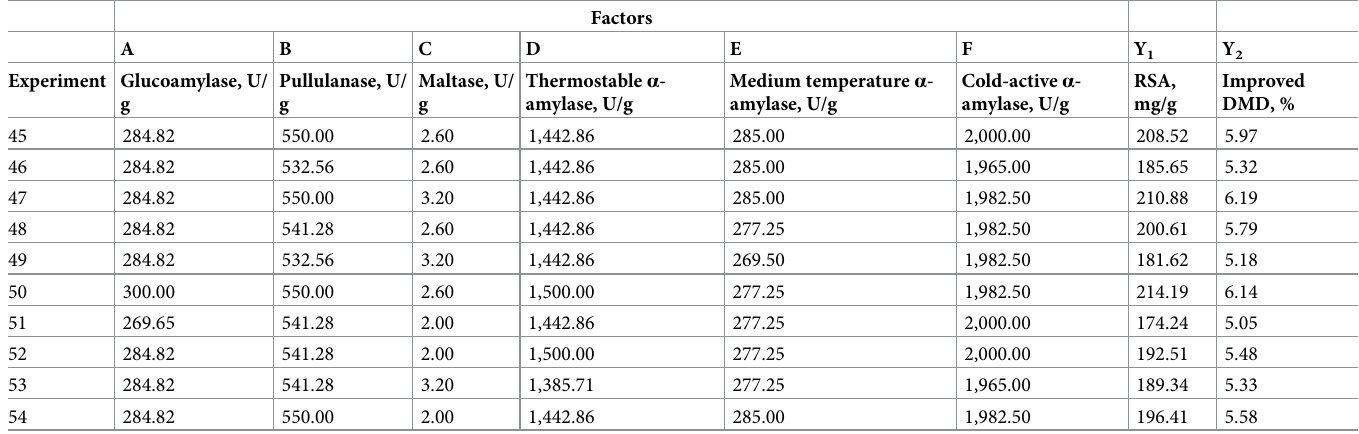
Three-dimensional images of the response surface were generated to demonstrate the signifi- cant interactions among the tested carborhydrases and the RSA as well as improved DMD in diets for broilers aged 1 to 3 wk. As showed in Table 6, the effects of all the interactions among tested exogenous carborhydrases on RSA were significant ( P < 0.01), which were demonstrated in Fig 1. Regarding to improved DMD, only interactions between A and F ( P = 0.0354), B and C ( P = 0.0061), B and F ( P = 0.0452), C and D ( P < 0.0001), C and F ( P = 0.0067), D and F ( P < 0.0001) showed significant effect, which were demonstrated in Fig 2. As seen in Eqs 4 and 5, the results of the predicted responses of RSA (Y DMD (Y ) in diets supplemented with exogenous carbohydrases according to previously 2 stated second-order polynomial Eq 3 are as follows,